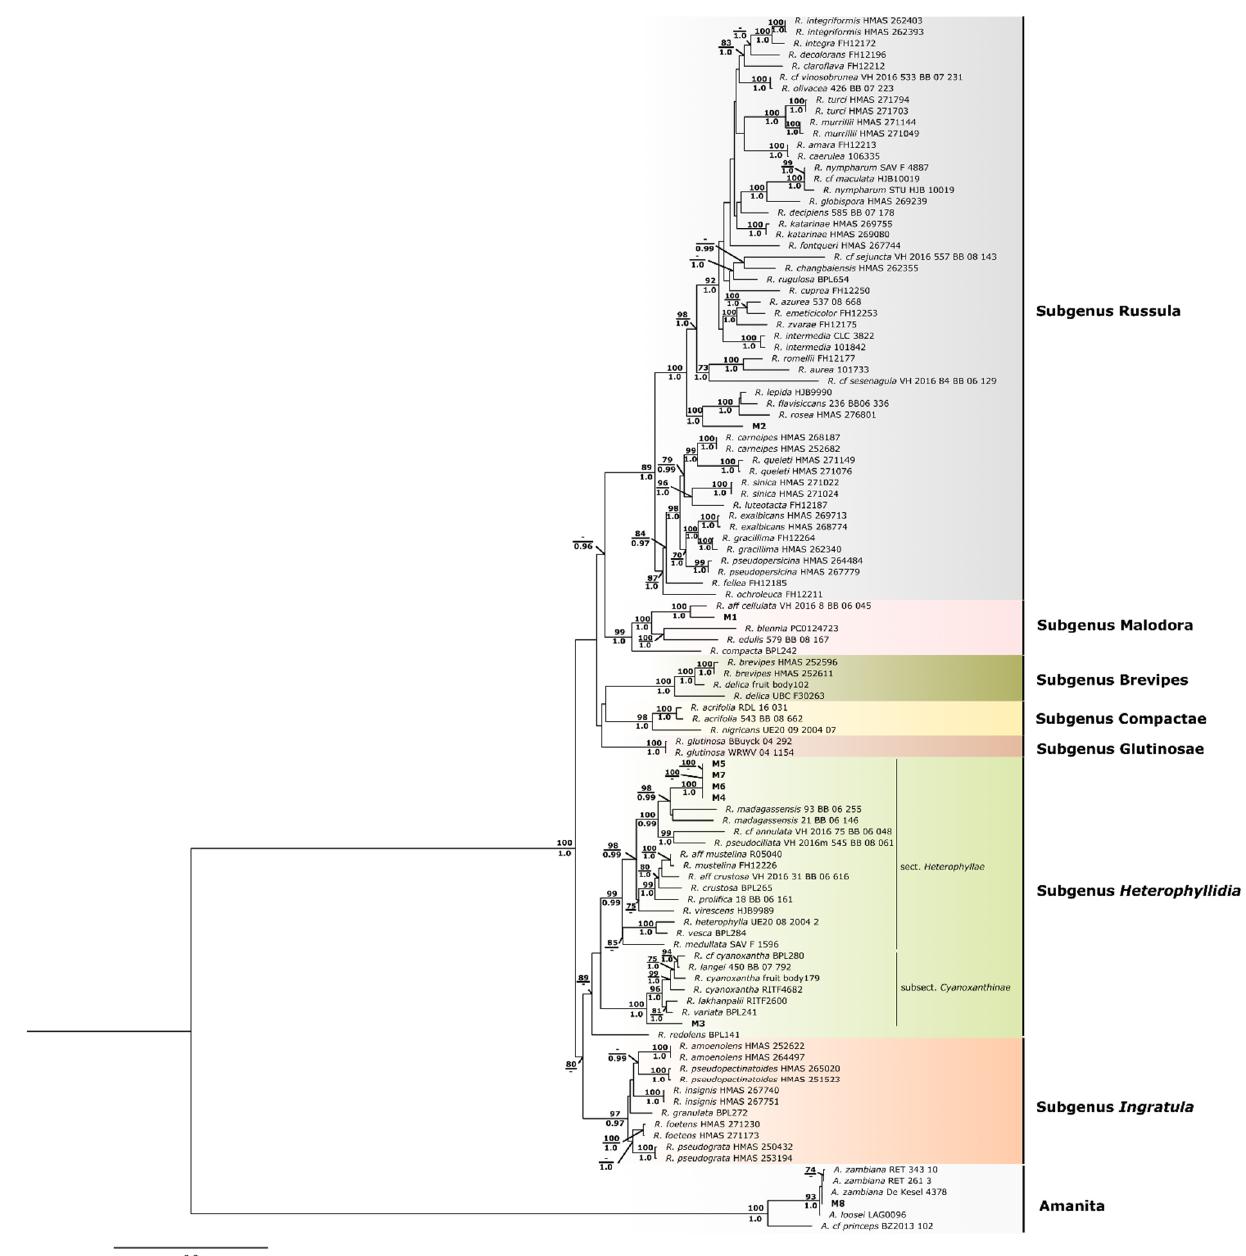
Figure 3. Maximum likelihood phylogenetic tree obtained from the concatenated dataset of ITS, LSU and rpb2 locus. ML Bootstrap support values and Bayesian posterior probability scores are given at the nodes (>70% and 0.95, respectively). The mushroom samples from Huila, Angola, numbered M1 to M8, are in bold.